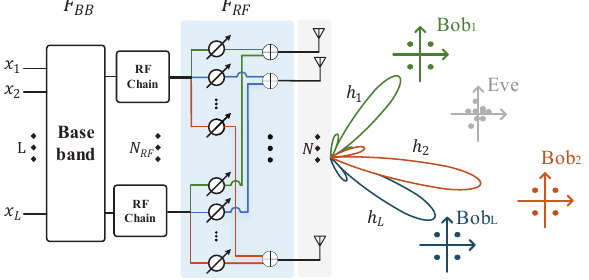
Figure 1. Multi-user millimeter wave security communication